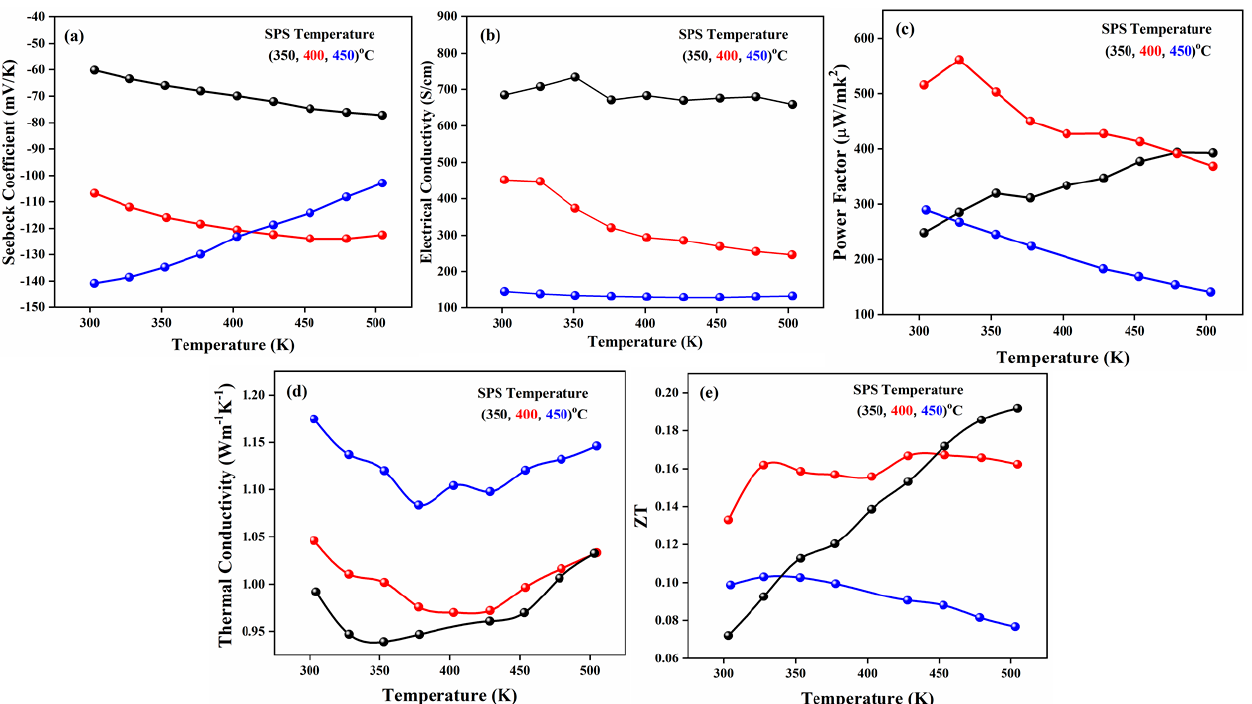
Figure 2. ( a ) S, ( b ) σ , ( c ) PF, ( d ) κ , and ( e ) ZT, of the n-type BT